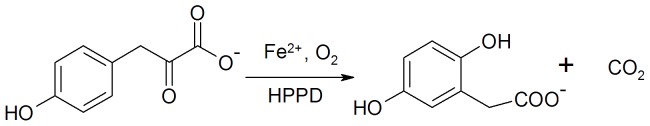
Catalytic conversion of HPP to HGA by HPPD.